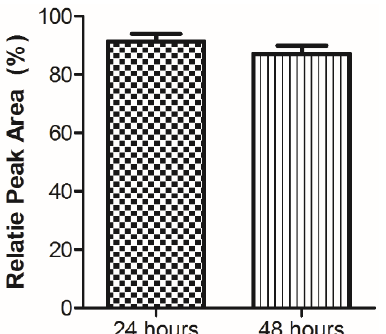
Figure 1. Peptide stability in plasma. Pentapeptide 1 was incubated in human plasma at 37 ◦ C. Levels of the peptide remaining after various time points were analyzed by RP-HPLC in the presence of 0.1% trifluoroacetic acid and detected by absorbance at 210 nm. Peptide amounts were calculated relative to quantities determined at time point zero, and data shown are the average ± SEM of three separate experiments. No statistical di ff erence was found between the two time points.